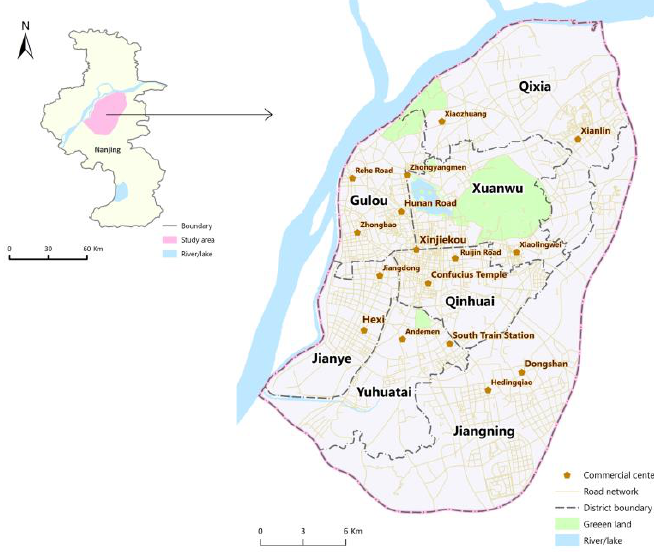
Figure 2. Nanjing municipal boundary and the study area.